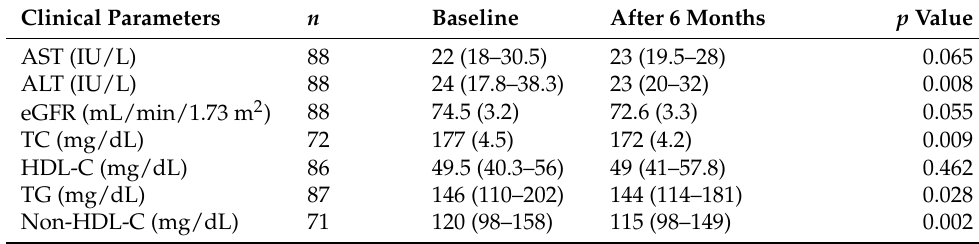
Table 2. Changes in cardiometabolic parameters after 6 months of oral semaglutide treatment.